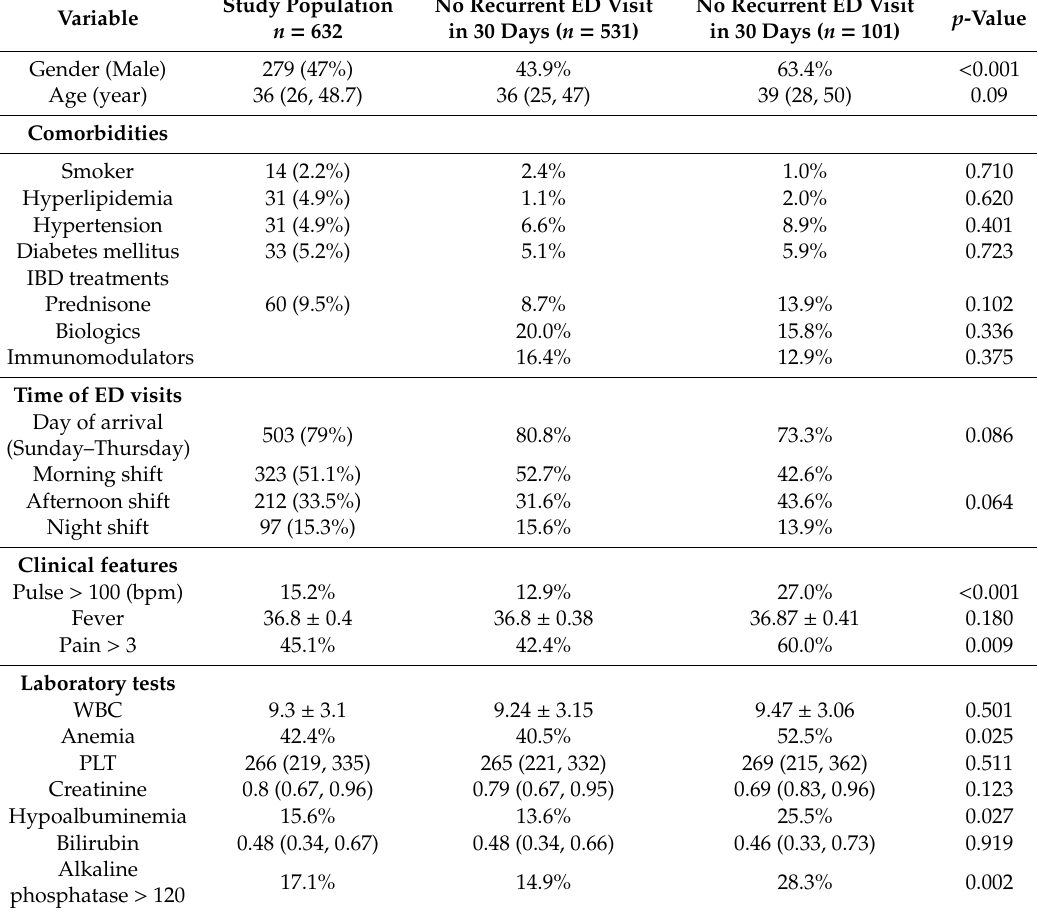
Table 3. Characteristics of the study population and